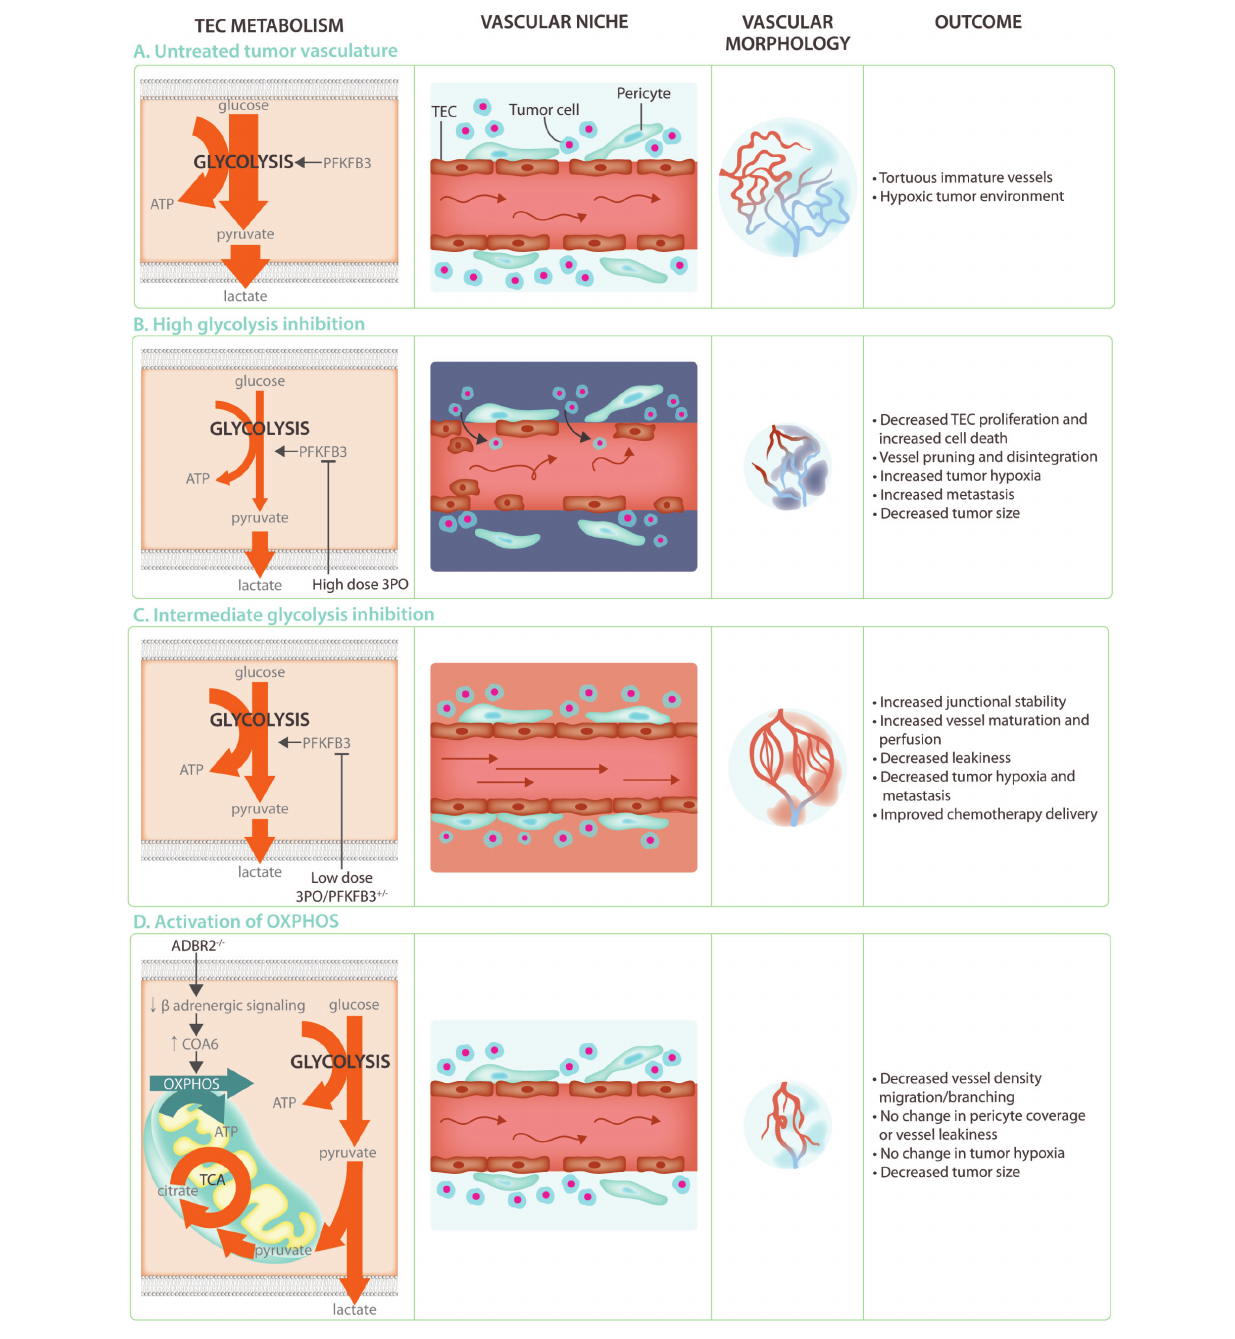
FIGURE 4 | Targeting TEC metabolism as anti-cancer treatment. (A) The hypoxic and acidic tumor microenvironment leads to hyperactivation of the tumor endothelium. This leads to TECs that are hyperglycolytic in comparison to normal endothelial cells, weakly connected due to decreased VE-Cadherin, and poorly covered by pericytes. These abnormal characteristics lead to poor perfusion and a worsening of the hypoxic and acidic tumor microenvironment establishing a loop of non-productive angiogenesis creating tortuous and immature tumor vasculature. (B) Targeting the hyperglycolytic TEC metabolism by high dose 3PO treatment decreases TEC proliferation and increases endothelial cell death. While this leads to increased vessel pruning, disintegration, and decreased tumor size, it also increases tumor hypoxia and metastasis. (C) Targeting TEC glycolysis by using low dose 3PO treatment, or in PFKFB3+/– mice, induces an intermediate brake on TEC metabolism leading to vessel normalization. Increased junctional stability due to decreased endocytosis of the junctional molecule VE-Cadherin allows for decreased vascular leakiness and increased vessel maturation. Normalization of the tumor vasculature improves tumor perfusion, hypoxia, and chemotherapy delivery while reducing metastasis. (D) While TECs rely mainly on glycolysis for ATP production, increasing OXPHOS through decreasing β -adrenergic signaling decreases migration and proliferation thereby preventing the angiogenic switch. This does not improve vessel maturation nor influence tumor hypoxia but reduces tumor